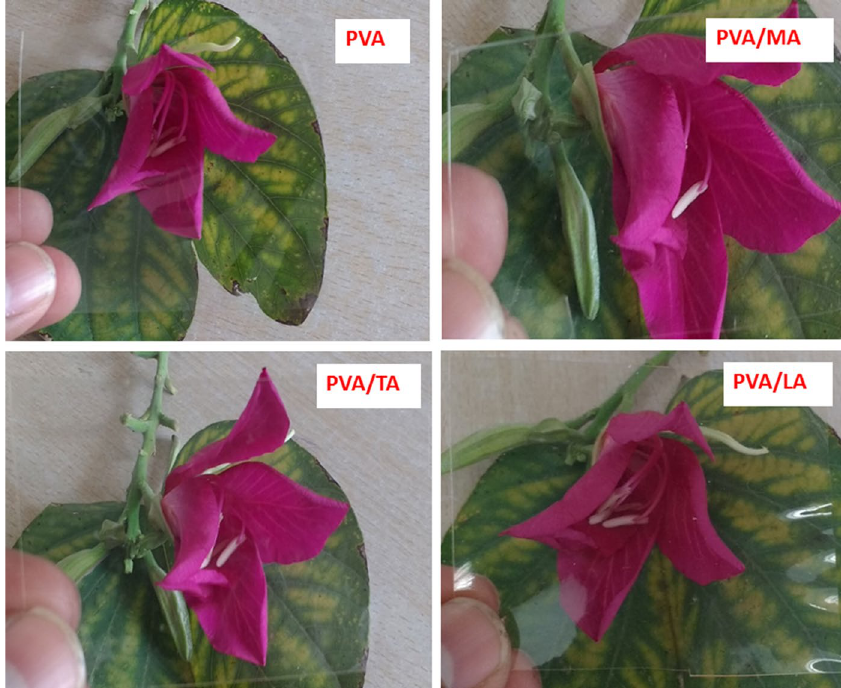
Fig. 1 The visual appearance of pristine PVA and cross-linked PVA films